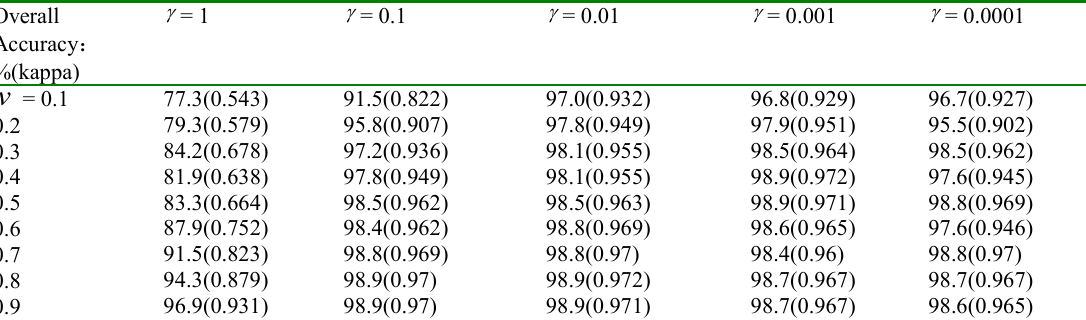
Figure 7 some results with different parameters Table 2 Change detection results with different